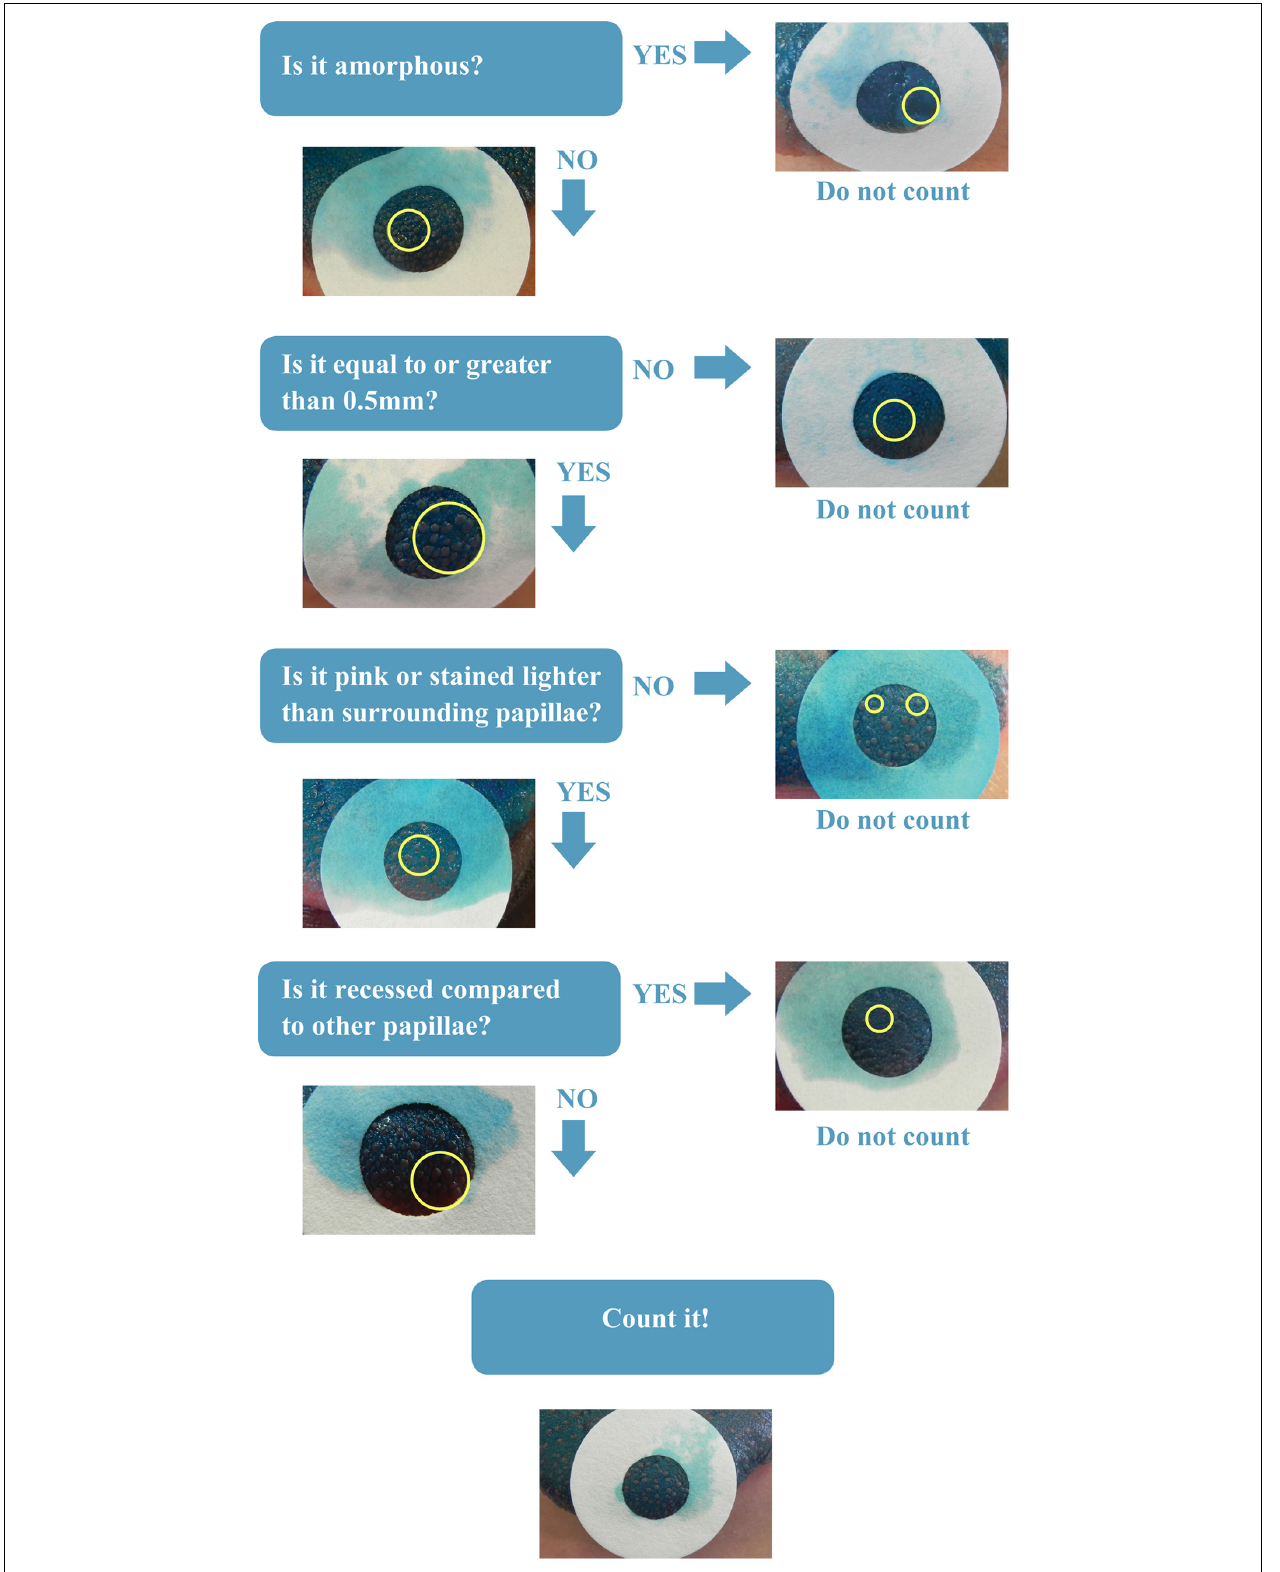
FIGURE 1 | Denver papillae protocol (DPP) dichotomous key. Prioritized flow chart of fungiform papillae characteristics.